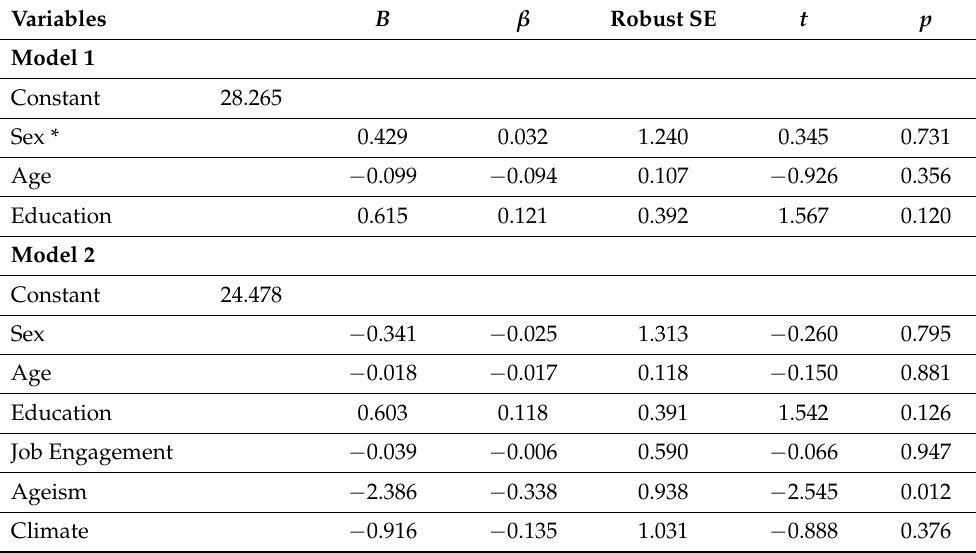
Table 4. Regression analysis: t -test based on robust standard errors